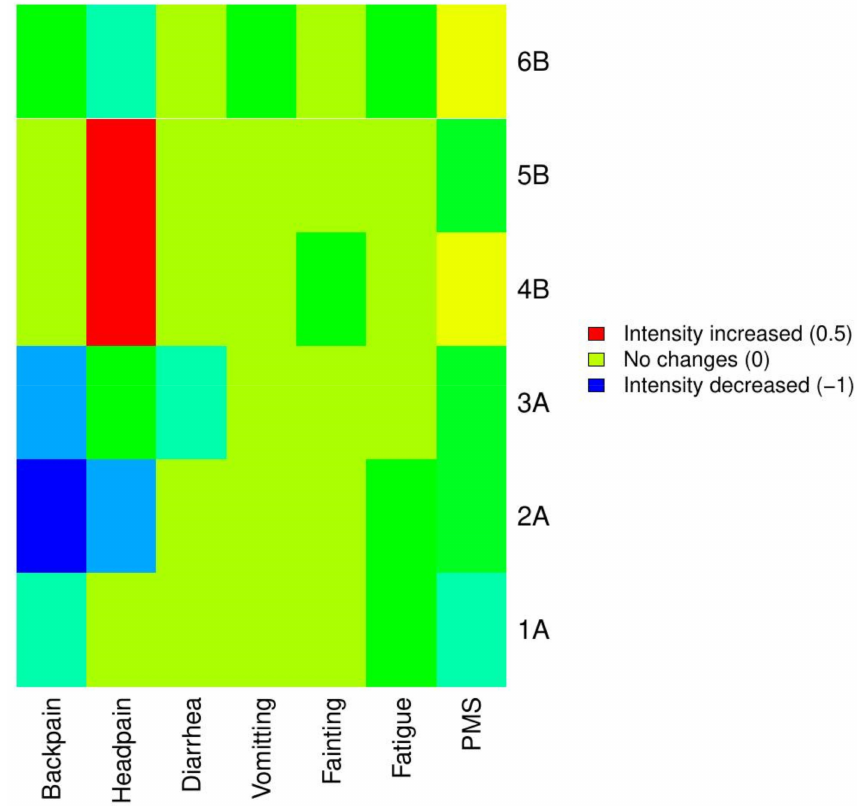
Figure 8. Changes in the intensity of additional symptoms and PMS after treatment among patients with dysmenorrhea in subgroups A and B. Red shows that intensity of symptoms was increased after treatment, whereas blue shows that intensity of symptoms was decreased after treatment. The predominant color in the diagram is that which describes no change in the pain